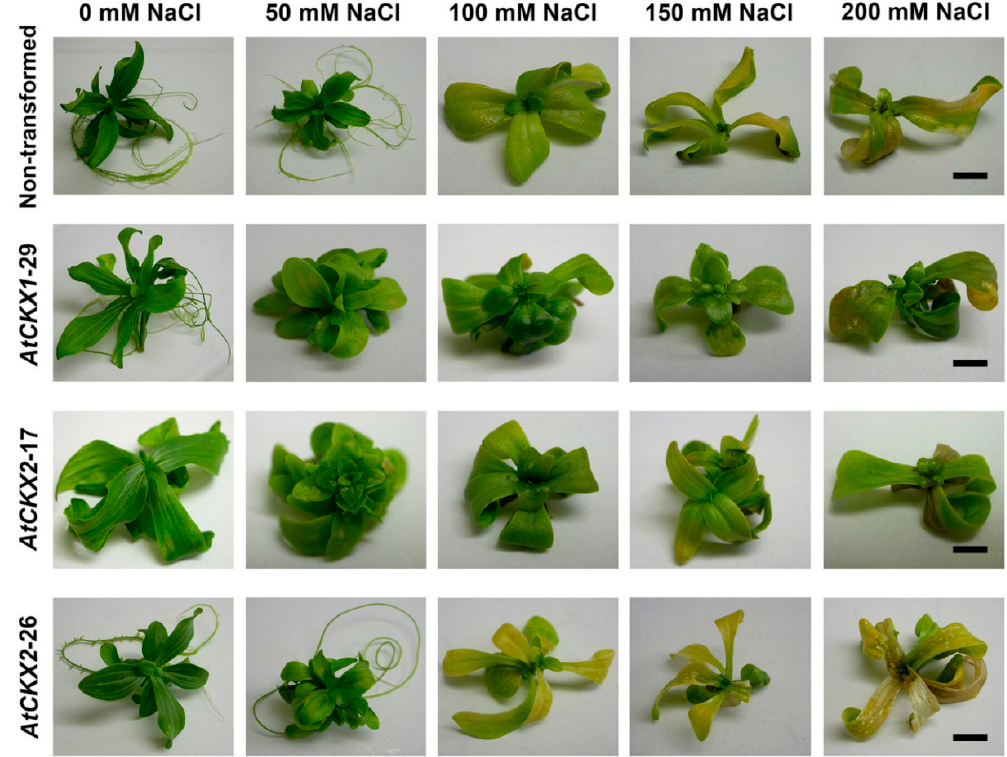
Figure 1. Eight-week-old non-transformed and AtCKX transgenic Centaurium erythraea shoots grown in ½MS medium supplemented with a range of NaCl concentrations (0-mM, 50-mM, 100-mM, 150-mM, and 200-mM). Bars indicate 10 mm.